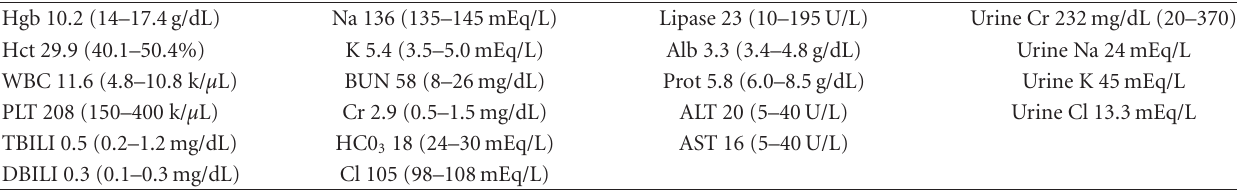
Table 1: Laboratory results from first hospitalization (normal values in parentheses).